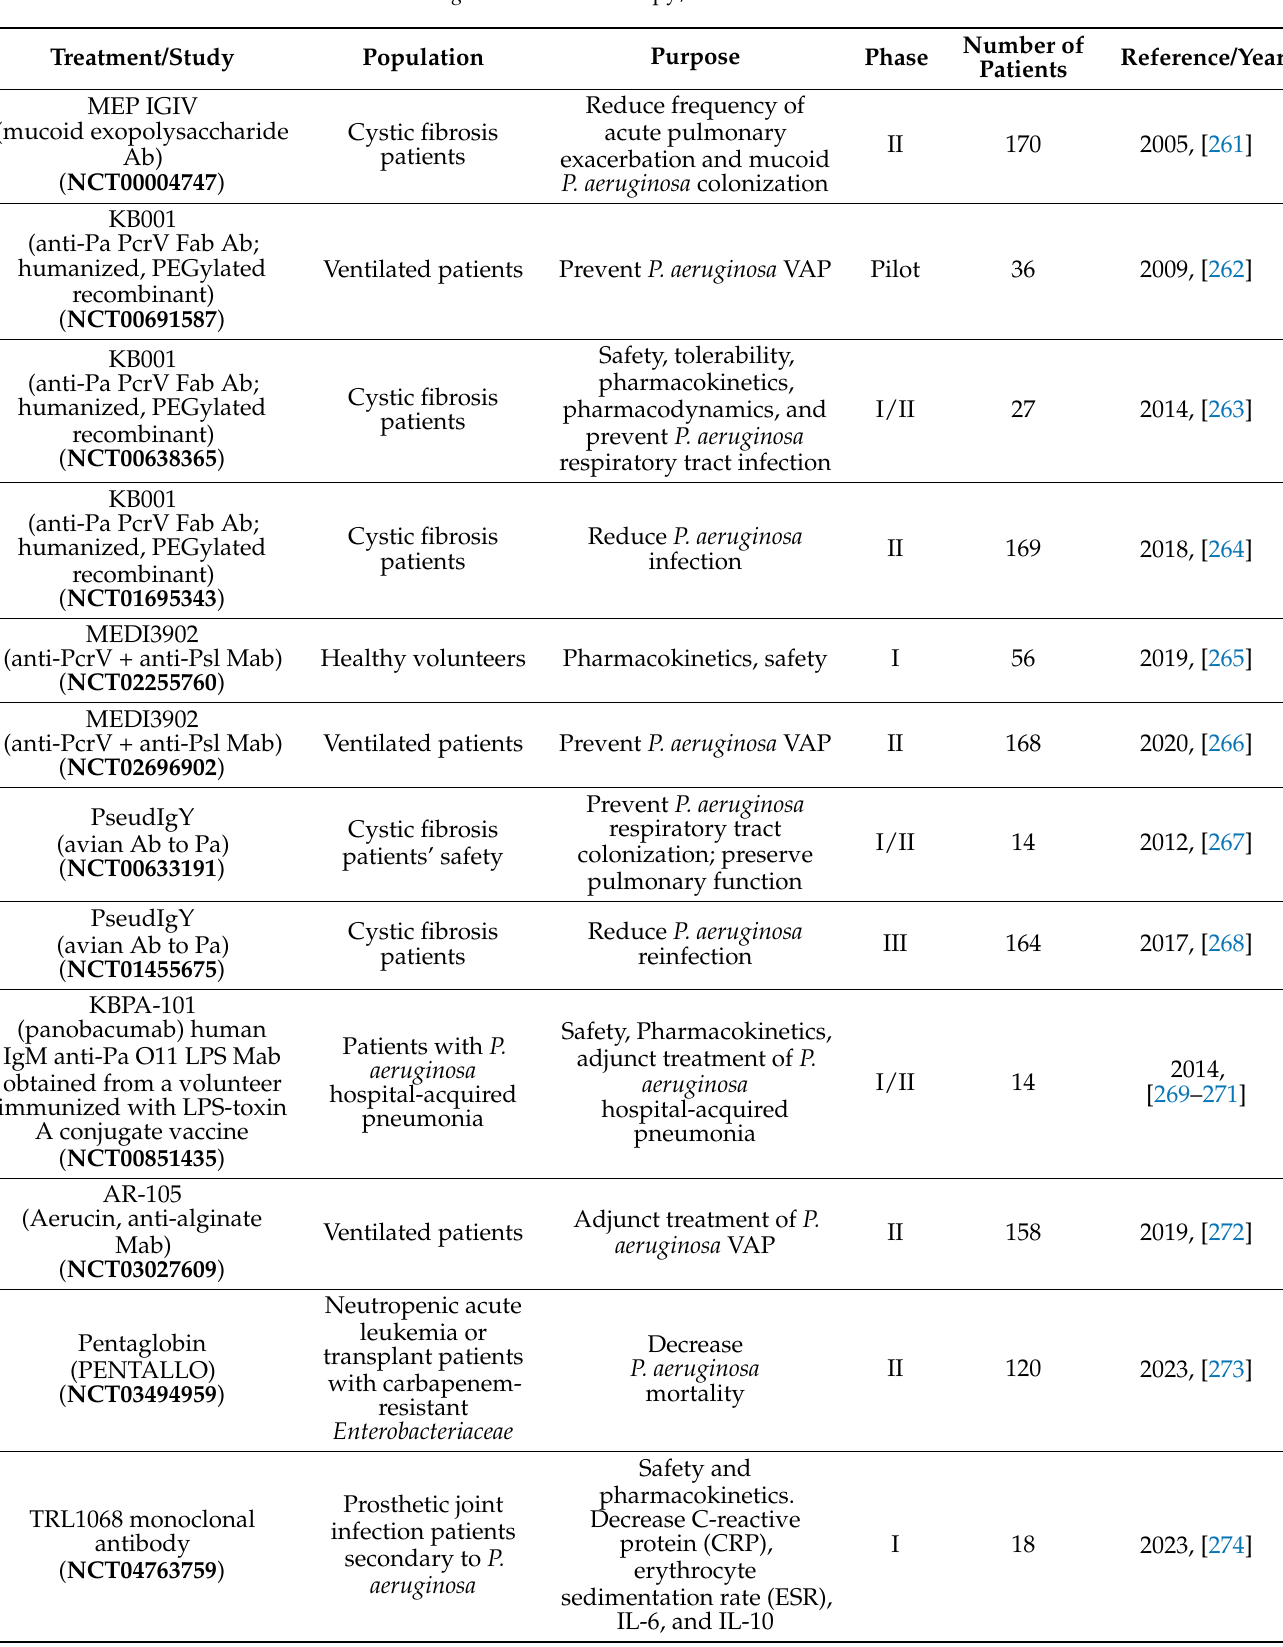
Table 4. P. aeruginosa immunotherapy/monoclonal